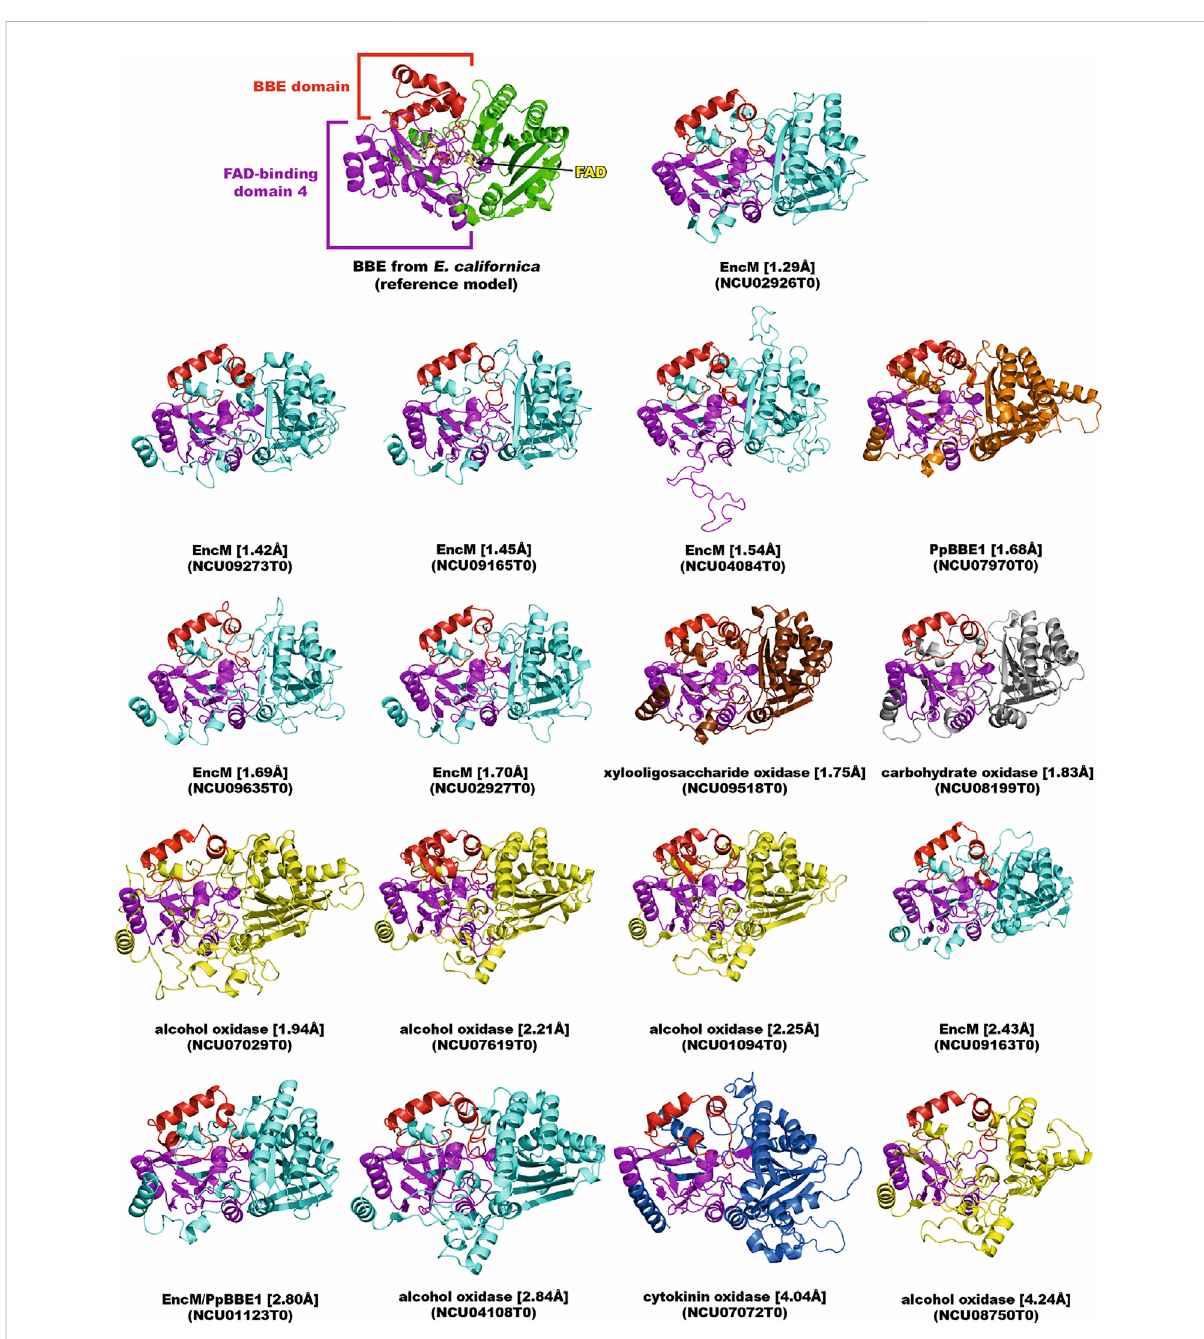
FIGURE 1 BBE-likeenzymesin N.crassa .ThecrystalstructureofBBEfrom Eschscholziacalifornica (PDBentry:3d2d)wasusedasareference(upperleft). The AlphaFold models of the BBE-like enzymes from N. crassa are shown according to their structural deviation (expressed as C α -RMSD) from the reference model. The BBE domain and the FAD-binding domain 4 of all enzymes are colored in red and magenta, respectively. The domains